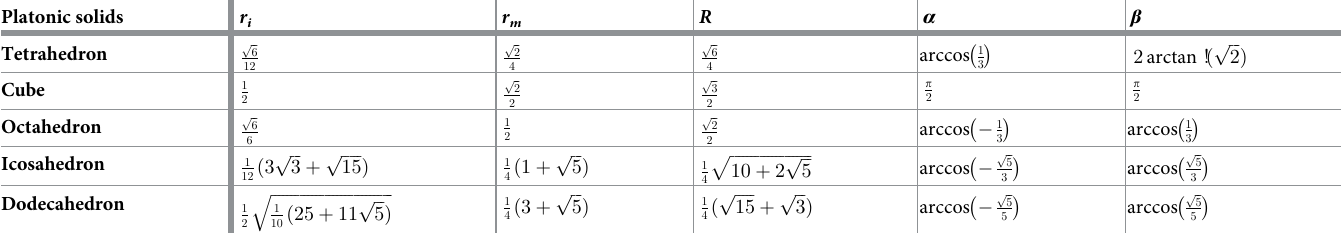
Table 2. Geometrical parameters of the Platonic solids with inradius ( r all the edges of the Platonic solids have the same unit length ( l = 1). Platonic